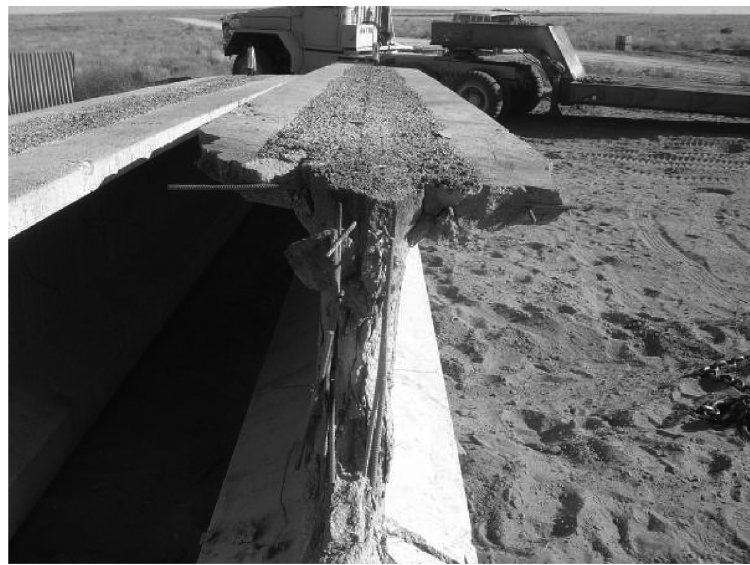
Fig. 9. Web cracking from blast above the